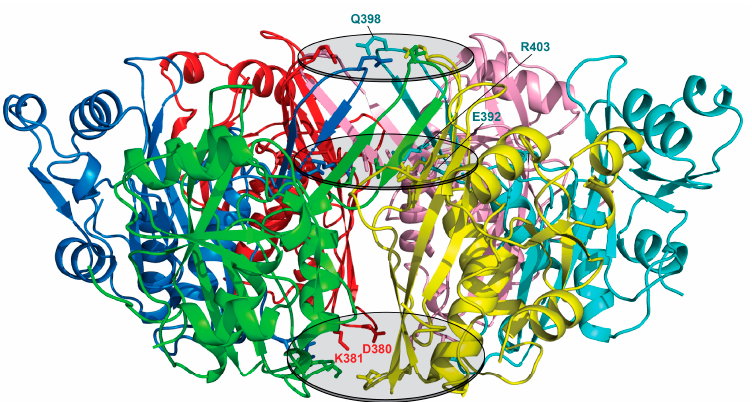
Figure 4. Hexamer of the protease (P) domain of Bs LonBA (side view). Six protomers of the protease domain forming a hexamer of Bs LonBA are shown in different colors. Three layers of charged or hydrophilic residues from each protomer form a planar arrangement (marked with shaded ovals) with their side chains (shown in sticks) oriented into the central chamber of a hexamer.